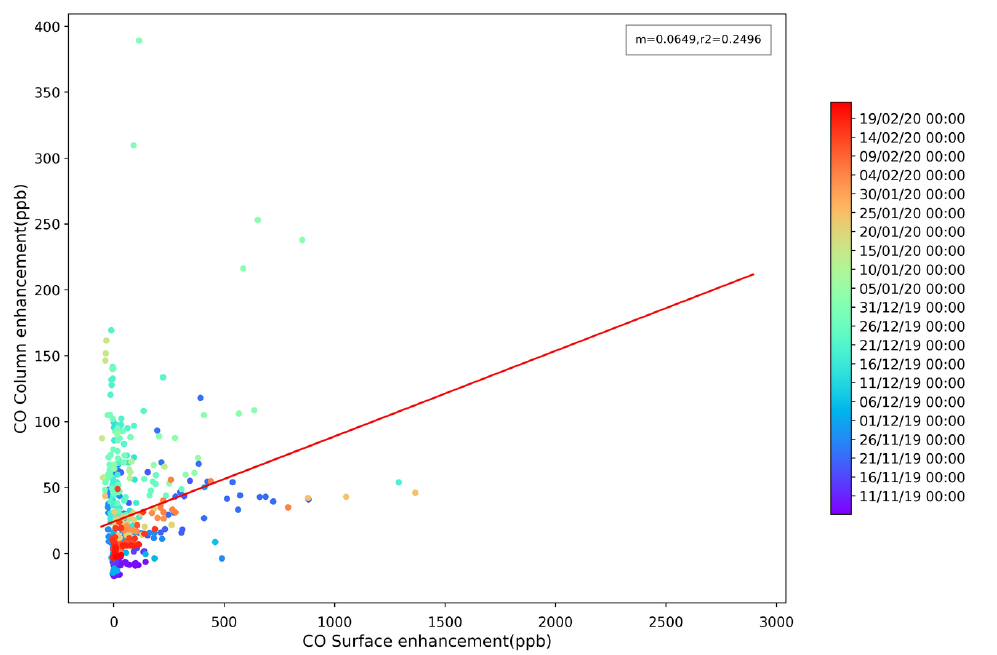
Figure A2. Correlation plot of total column CO enhancement vs surface